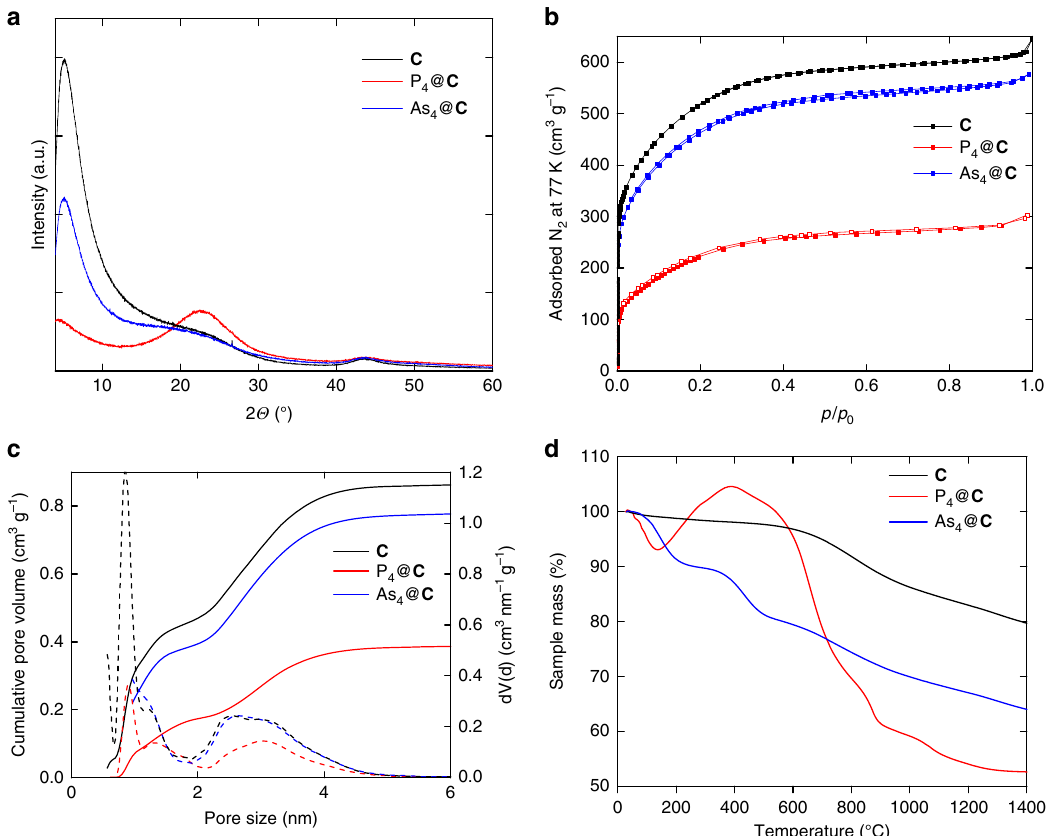
Fig. 2 Comparisons of unloaded carbon material C (black), P 4 @ C (red) and As 4 @ C (blue). a Powder X-ray diffractograms. b Nitrogen physisorption isotherms at 77 K. c DFT pore size distribution. d Thermogravimetric curve